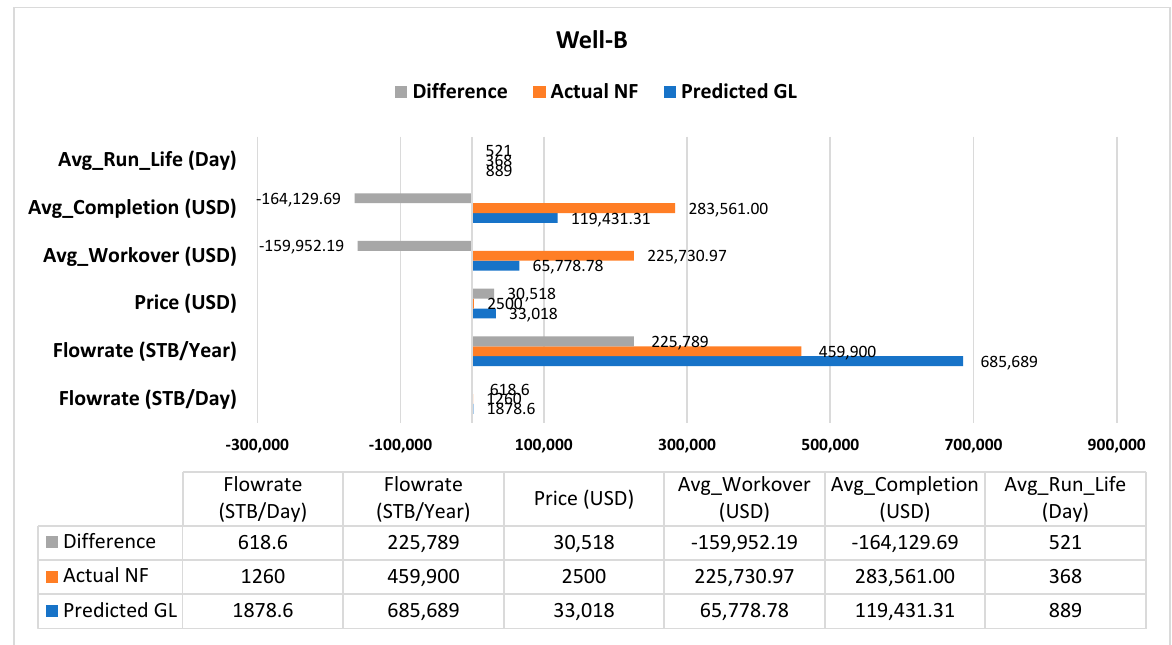
Figure 10. Well-B production and cost di ff erence of actual and predicted AL.